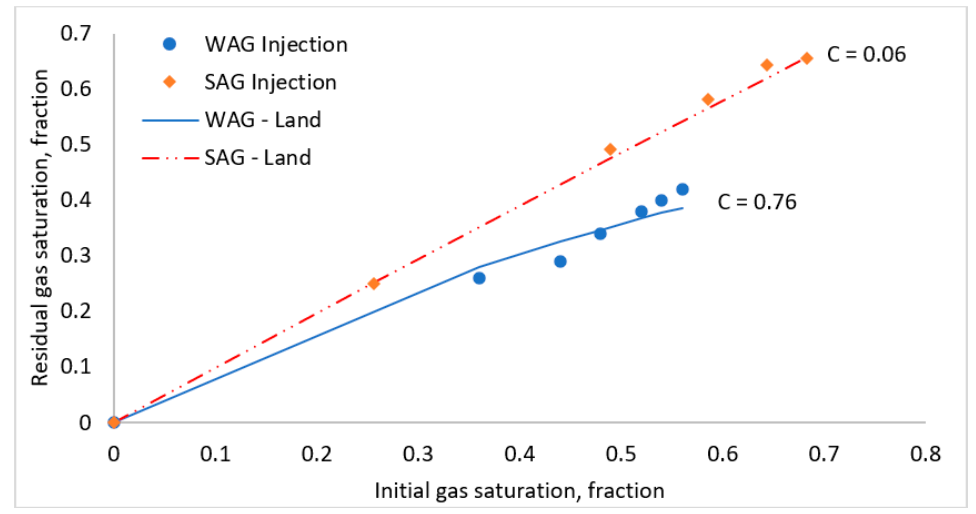
Figure 7. Initial–residual saturation curves of the GD sample under WAG (blue symbols) and SAG injection (orange symbols). The solid and dashed lines show the best-fit Land’s model and the corresponding value of the C coefficients for the WAG and SAG injection process, respectively.